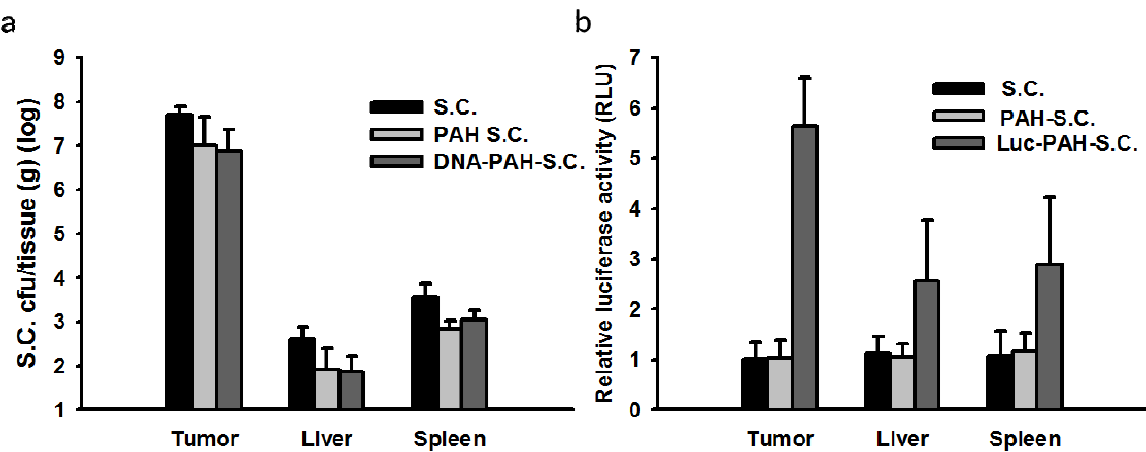
Figure 4. Tumor-targeting potential and gene transfer of Salmonella (S.C.) coated with PAH and DNA. Mice were subcutaneously injected with tumor cells (10 6 ). ( a ) Mice bearing 4T1 tumors ranging from 50 to 100 mm 3 were injected i.v. with S.C., PAH-S.C., or DNA-PAH-S.C. (2 × 10 6 cfu) at day 7, and the numbers of Salmonella cells in the tumors, livers, and spleens were determined at 10 days post-infection. The data are reported as the means ± SD ( n = 4); and ( b ) The mice bearing 4T1 tumors were injected i.v. with 2 × 10 6 cfu of S.C., PAH-S.C., or Luc-PAH S.C.; and the expression levels of luciferase in tissues derived from the various modified, S.C.-treated mice at day 1 post-infection were determined using luciferase assays. The data are reported as the means ± SD ( n =